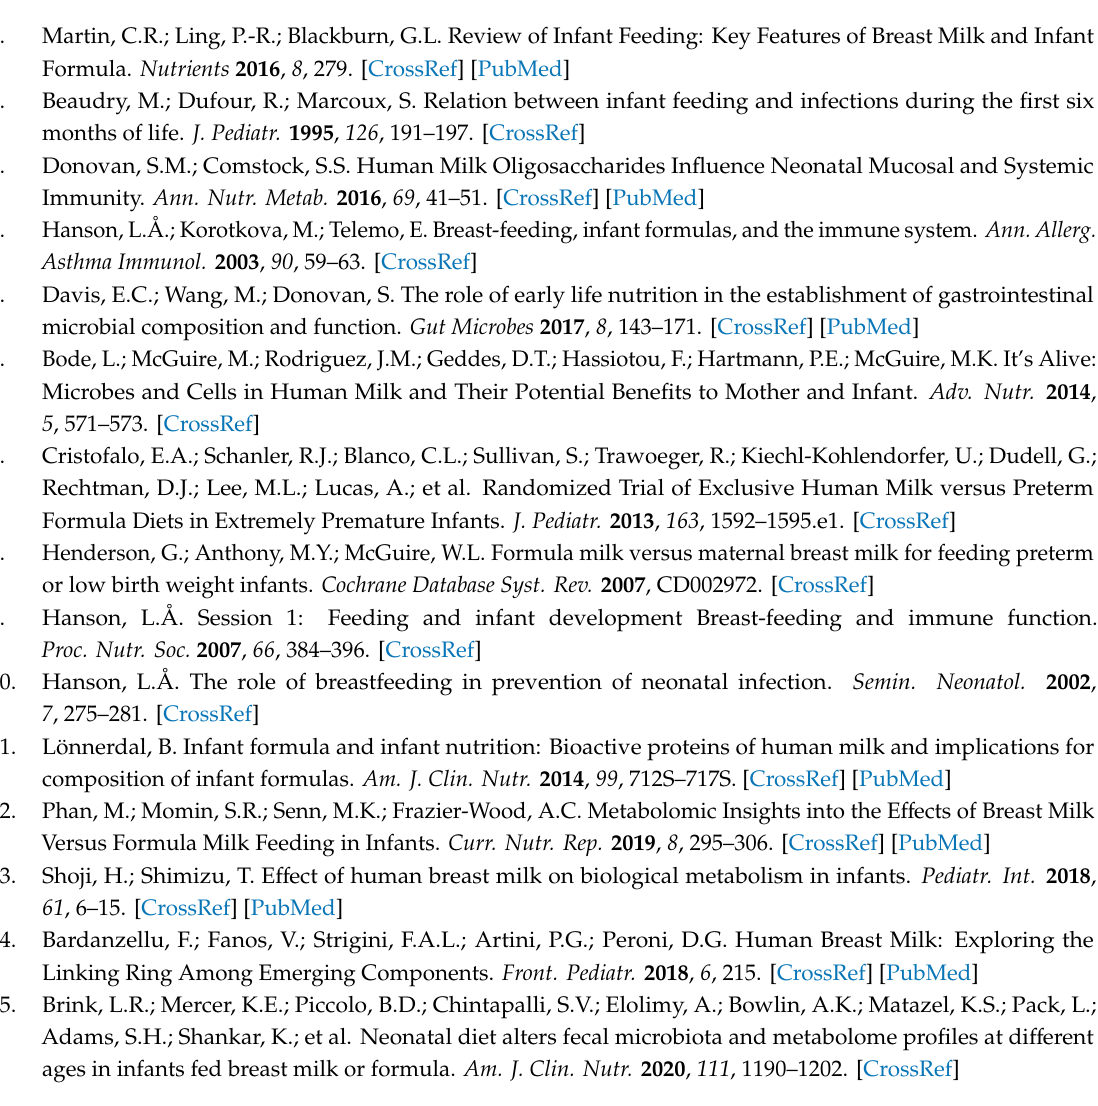
Table S1: Composition of the infant formulas used in this study. Table S2: Raw peak intensities (mz / rt) of all the known metabolites detected in the urine of infants at 3 months of age fed human milk (HM), cow’s milk-based formula (MF), or soy-formula (SF). Table S3: Average abundances (quantifier ion [quantion] intensities) of